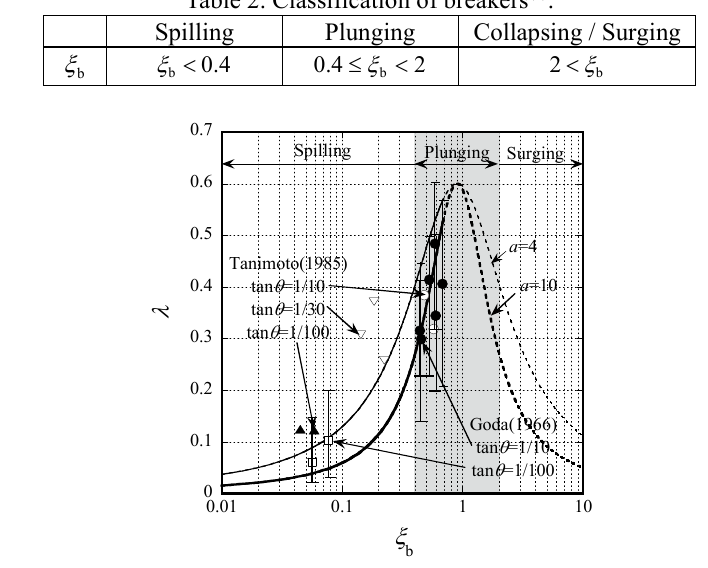
and curling factor b